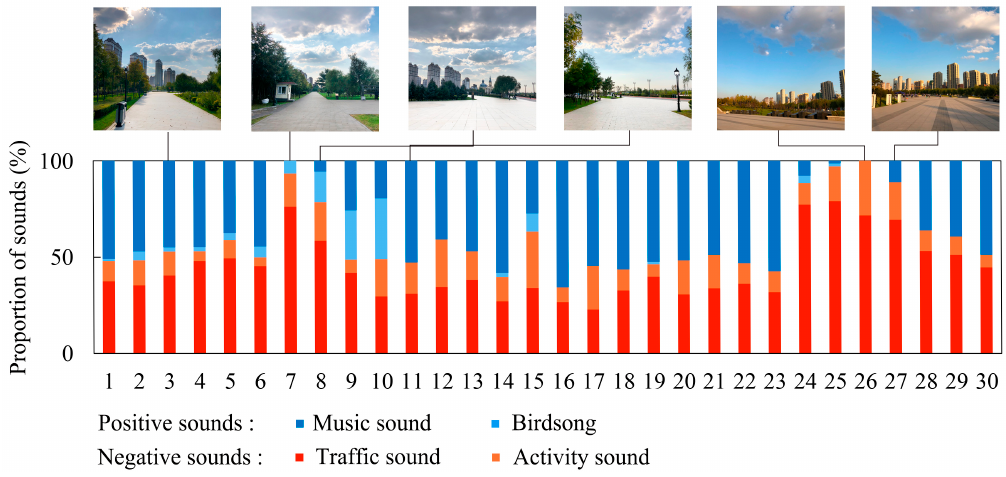
Figure 4. Proportion of sounds in each survey point and photographs in typical survey points in Music Park.